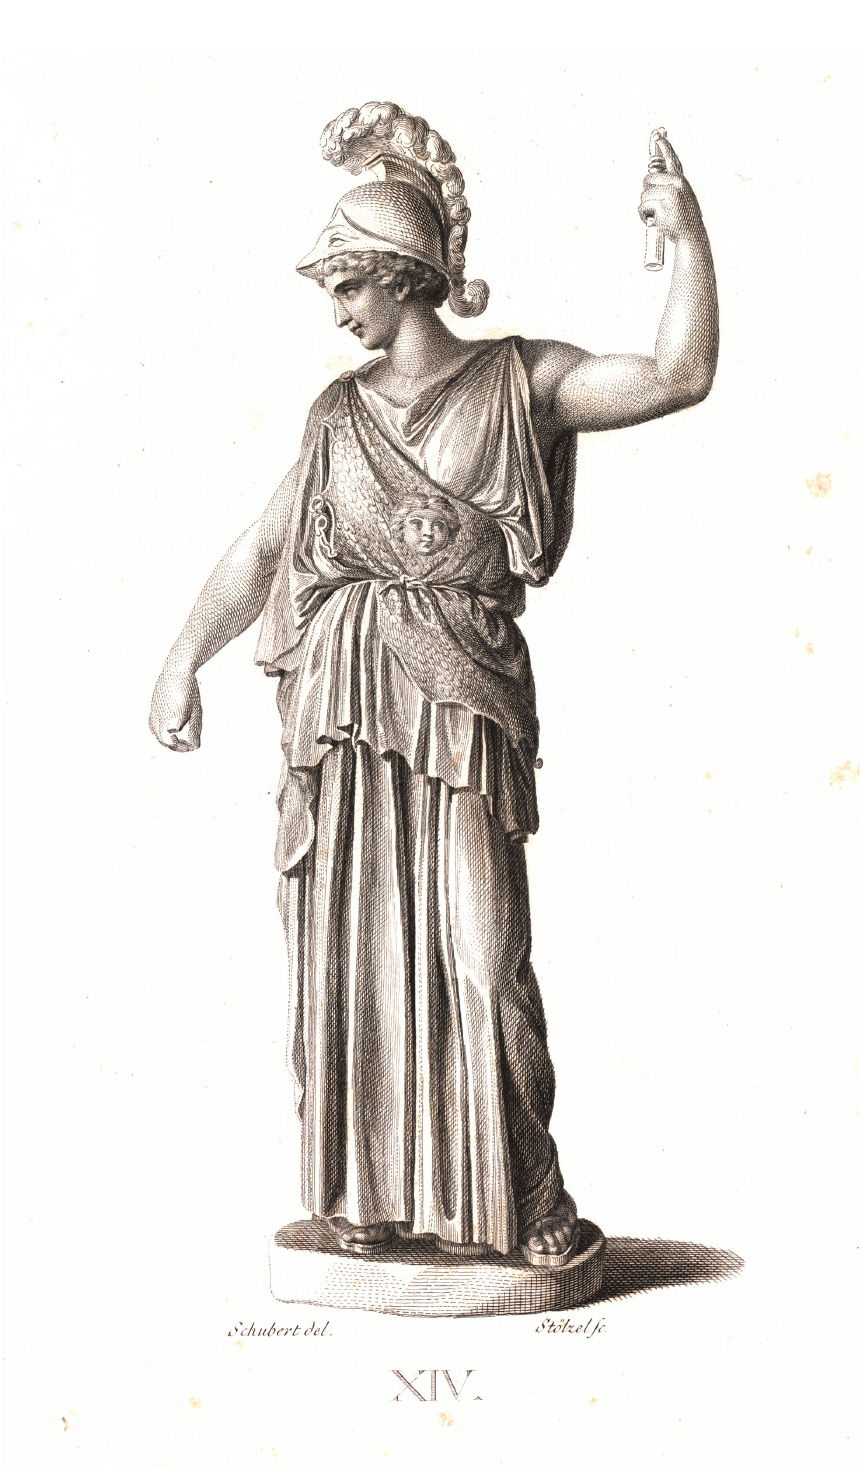
Contemporaneity: Historical Presence in Visual Culture http://contemporaneity.pitt.edu